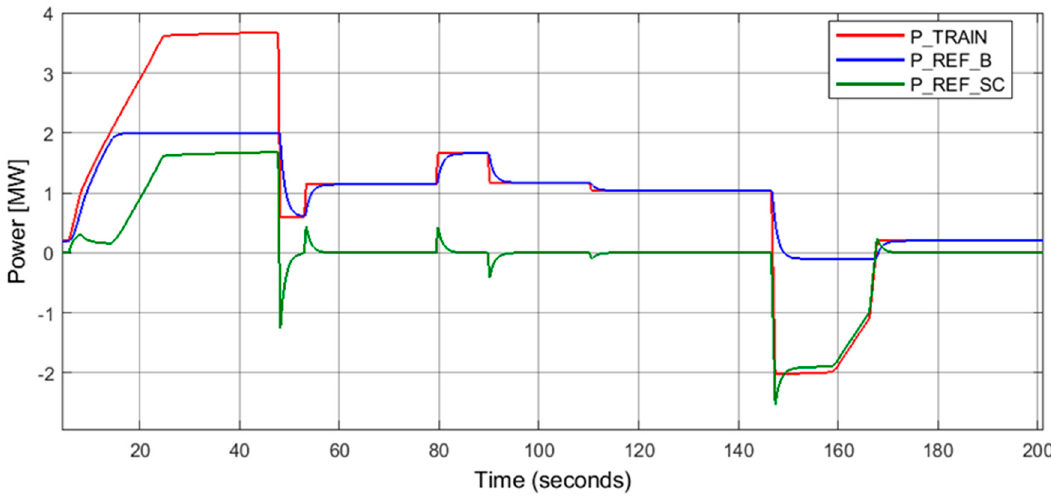
Figure 18. Power profiles H-ESS.